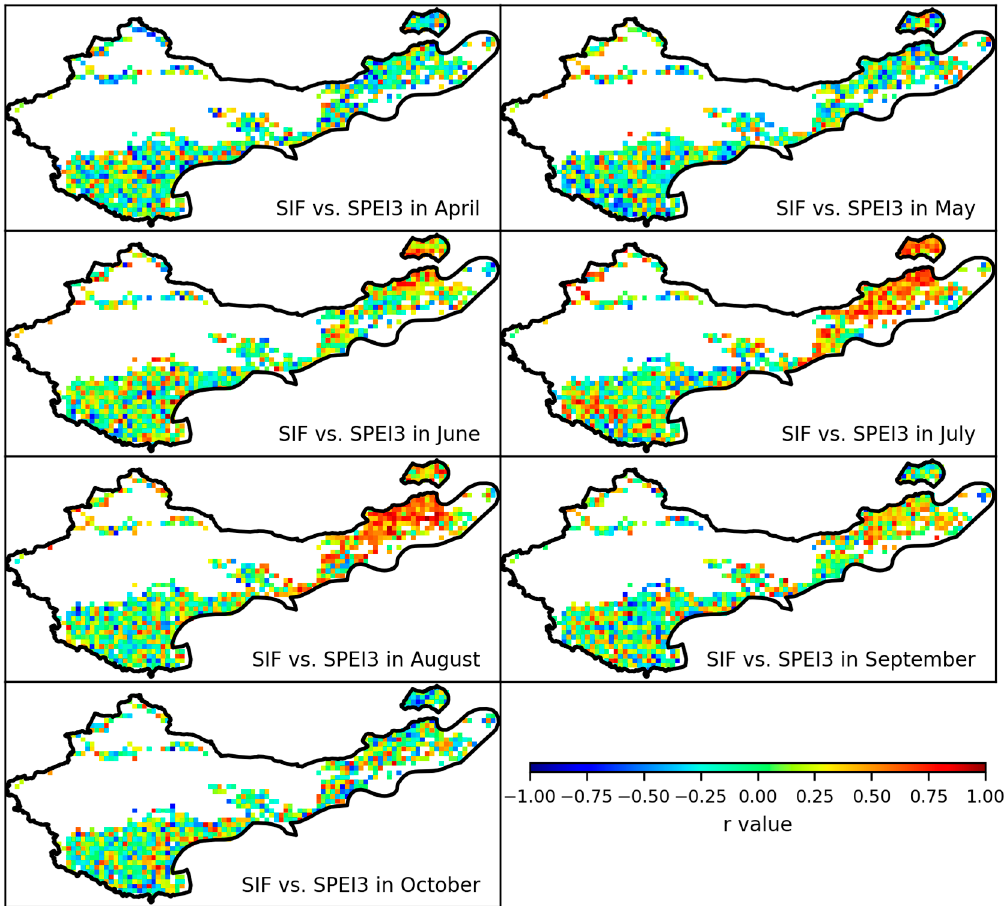
Figure 3. Spatiotemporal distribution of the correlation coefficients between SIF and three-month SPEI (SPEI-3) time scale. Pixels with white color mean non-grassland or missing data.